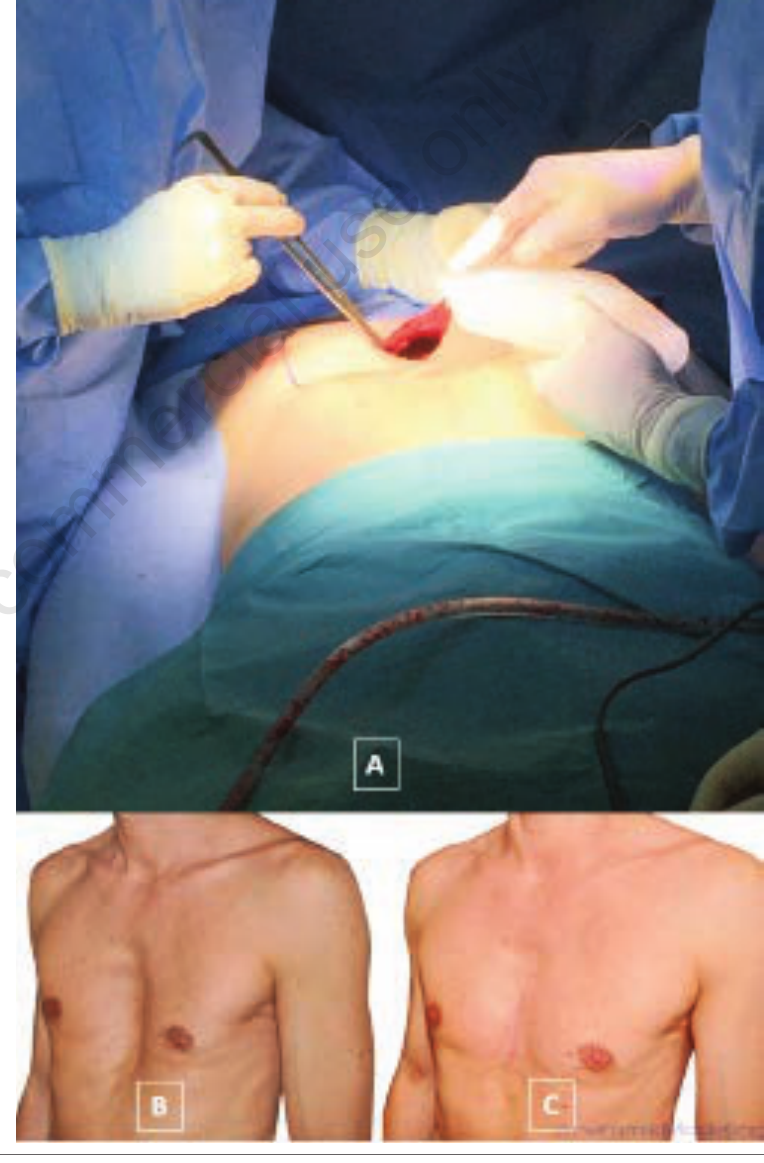
Figure 6. Insertion of a custom-made silicone implant for repair of a pectus excavatum deformity (A). Images of a pectus excavatum deformity prior to the procedure (B) and the cosmetic result following insertion of an implant (C).